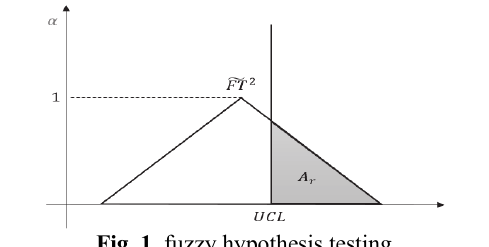
Fig. 1. fuzzy hypothesis